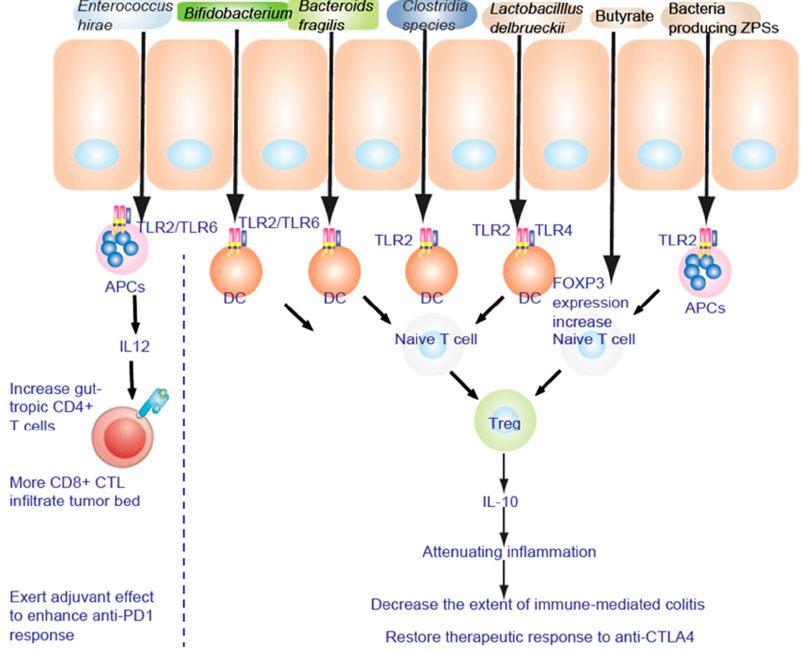
Figure 3. TLR2 is necessary to alleviate the inflammatory response. Fructo-oligosaccharide and in- ulin are considered as prebiotics, affecting IECs to be hyporesponsive to activation of NF- κ B and MAPK induced by pathogens. NF- κ B and MAPK reduce the inflammatory response to lipopoly- saccharide